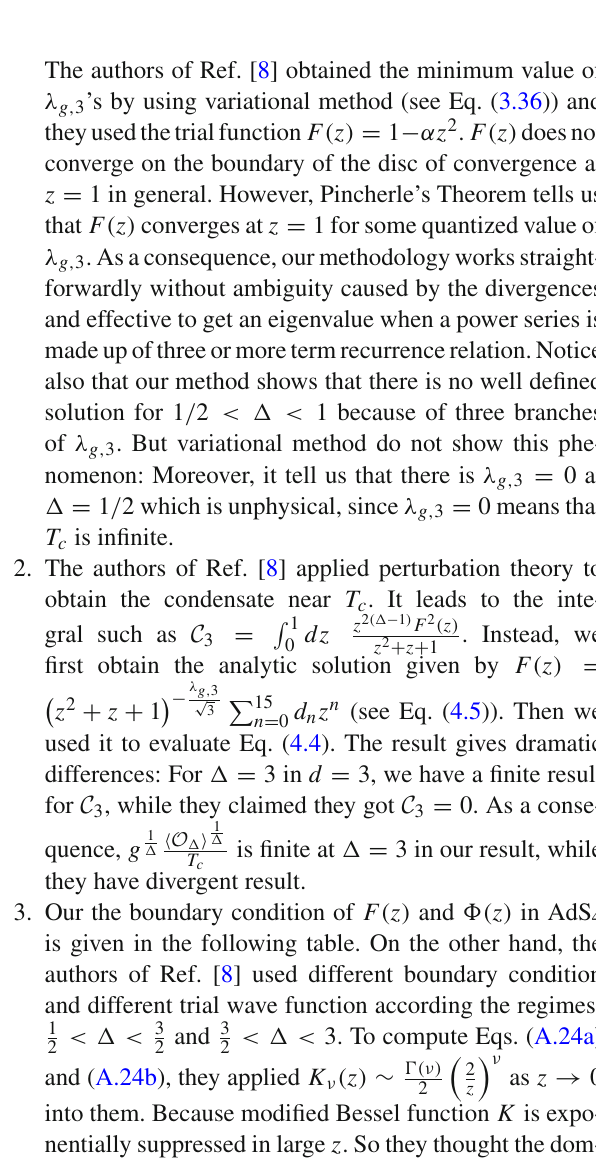
Fig. 25 a X vs T / T c : red colored curves for X is a plot of Eq. (B.52). And blue curves is a plot of Eq. (B.53). These two curves are almost identical for low temperature. b X 6 vs log ( T / T c ) at (cid:2) = 2: the slope of red dotted line for X 6 is −